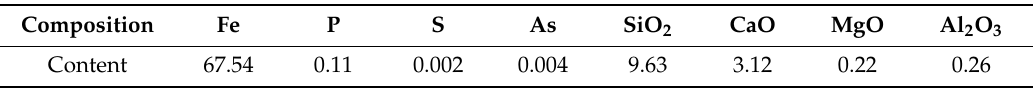
Table 5. Chemical analyses of iron concentrate obtained in single-pass low-intensity magnetic separation–reverse flotation process